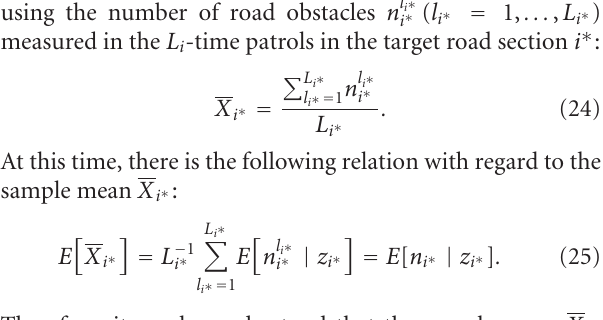
the above equation, by specifying the confidence level and risk management limit. The expected number E [ n i | z i ] is ( z i ) whose confidence level identical to the VaR value VaR α 0 . 5 is equal to 0.5. According to the definition of the VaR index, when ω < 0 . 5, E [ n i | z i ] < VaR α ω ( z i